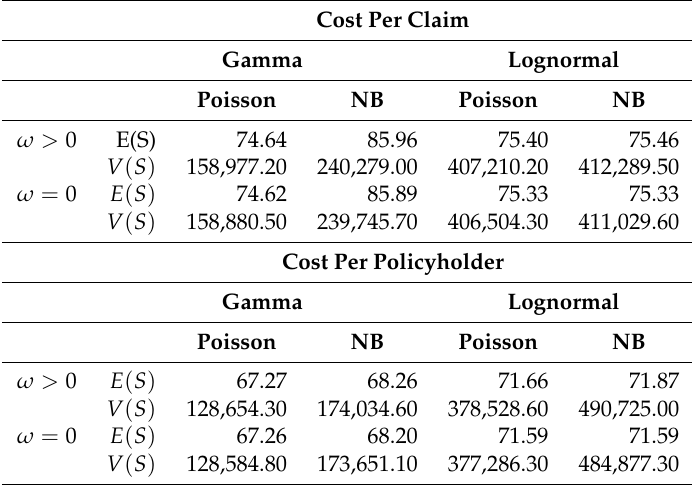
Table 4. Expectation and variance of S obtained from the estimated Sarmanov models, and by assuming independence ( ω =